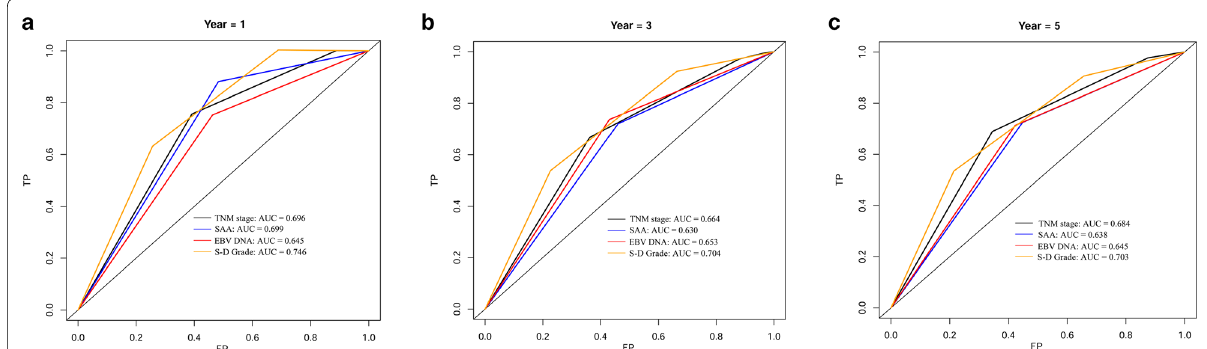
Fig. 3 Time-dependent ROC analysis of TNM stage, SAA, EBV DNA, and S-D grade for 1-, 3-, and 5-year OS in NPC patients